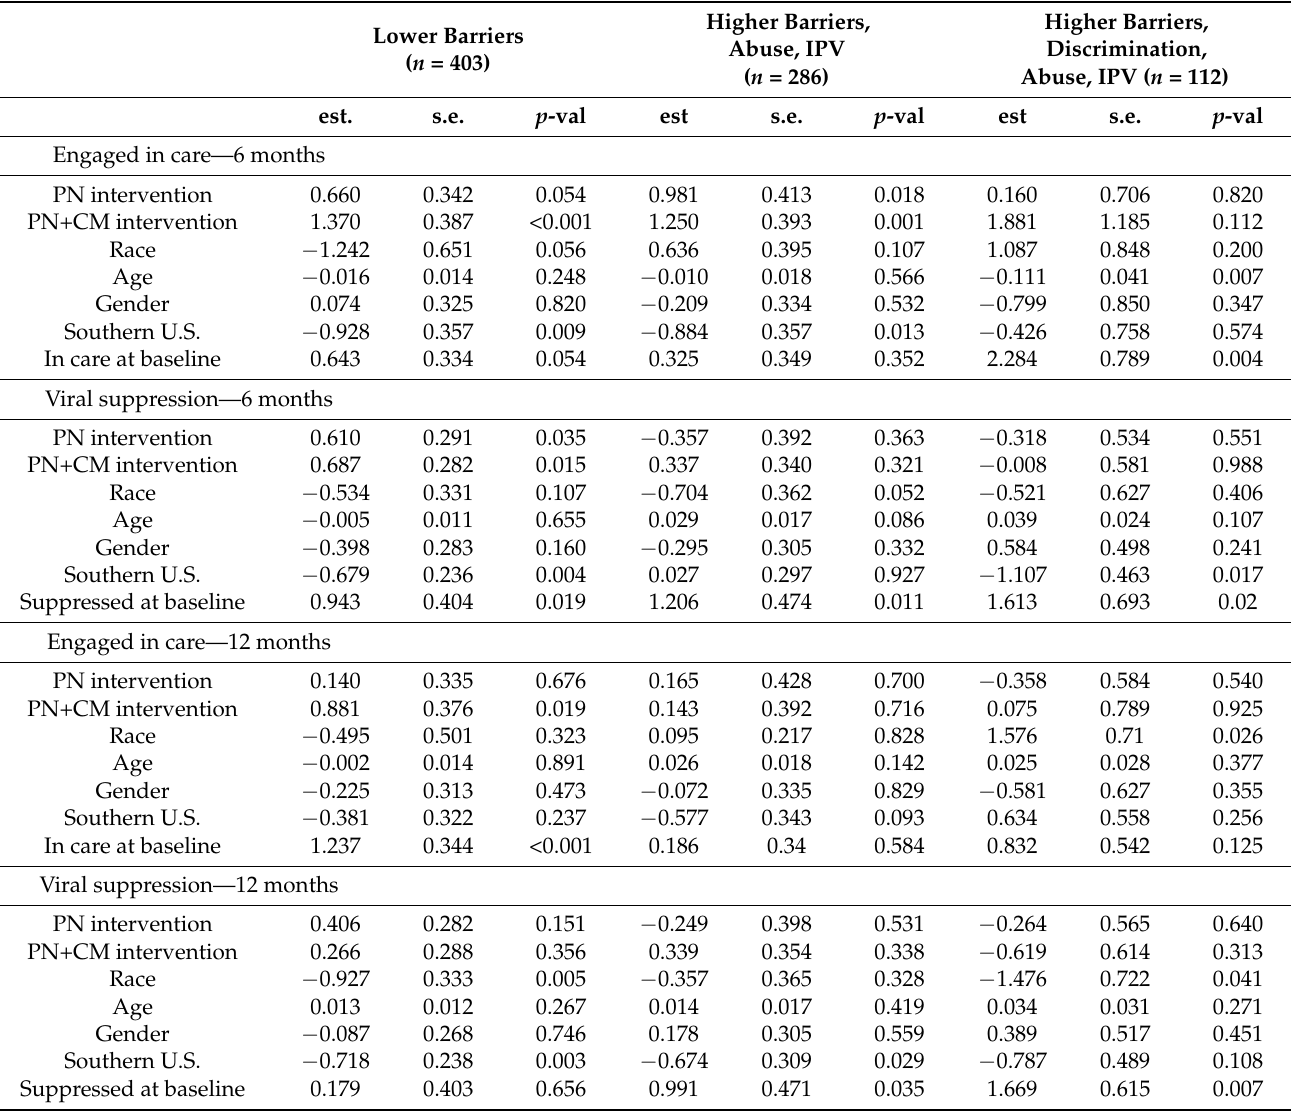
Higher Barriers,